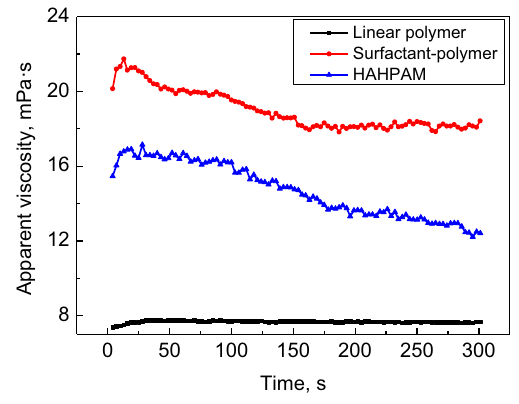
Fig. 10 Viscosity plotted as a function of time for HAHPAM at a constant shear rate of 104.40 s −1 , linear polymer, and surfactant–pol- ymer in brine (salinity = 9000 mg L −1 , [Ca 2+ ] + [Mg 2+ ] = 900 mg L −1 , T = 65 °C, Cp = 0.2